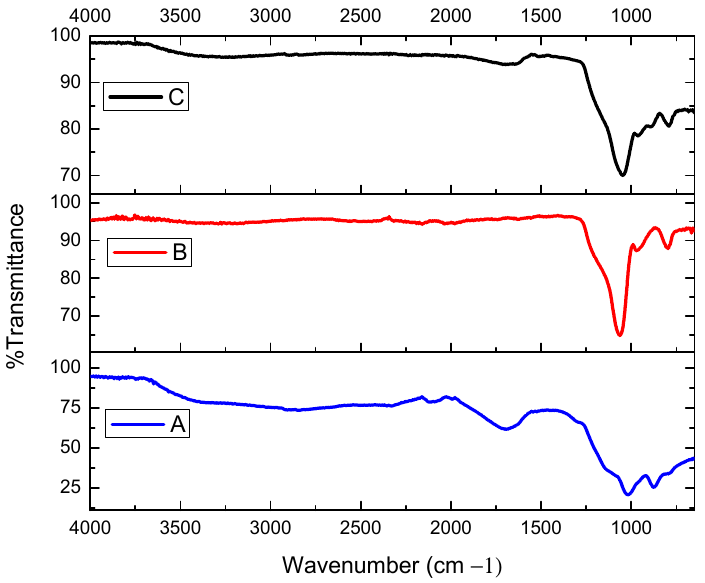
Figure 2. The FT-IR spectra of ( A ) the immobilized sulfuric acid on silica gel, ( B ) silica gel without catalyst, and ( C ) recovered catalyst after five cycles.